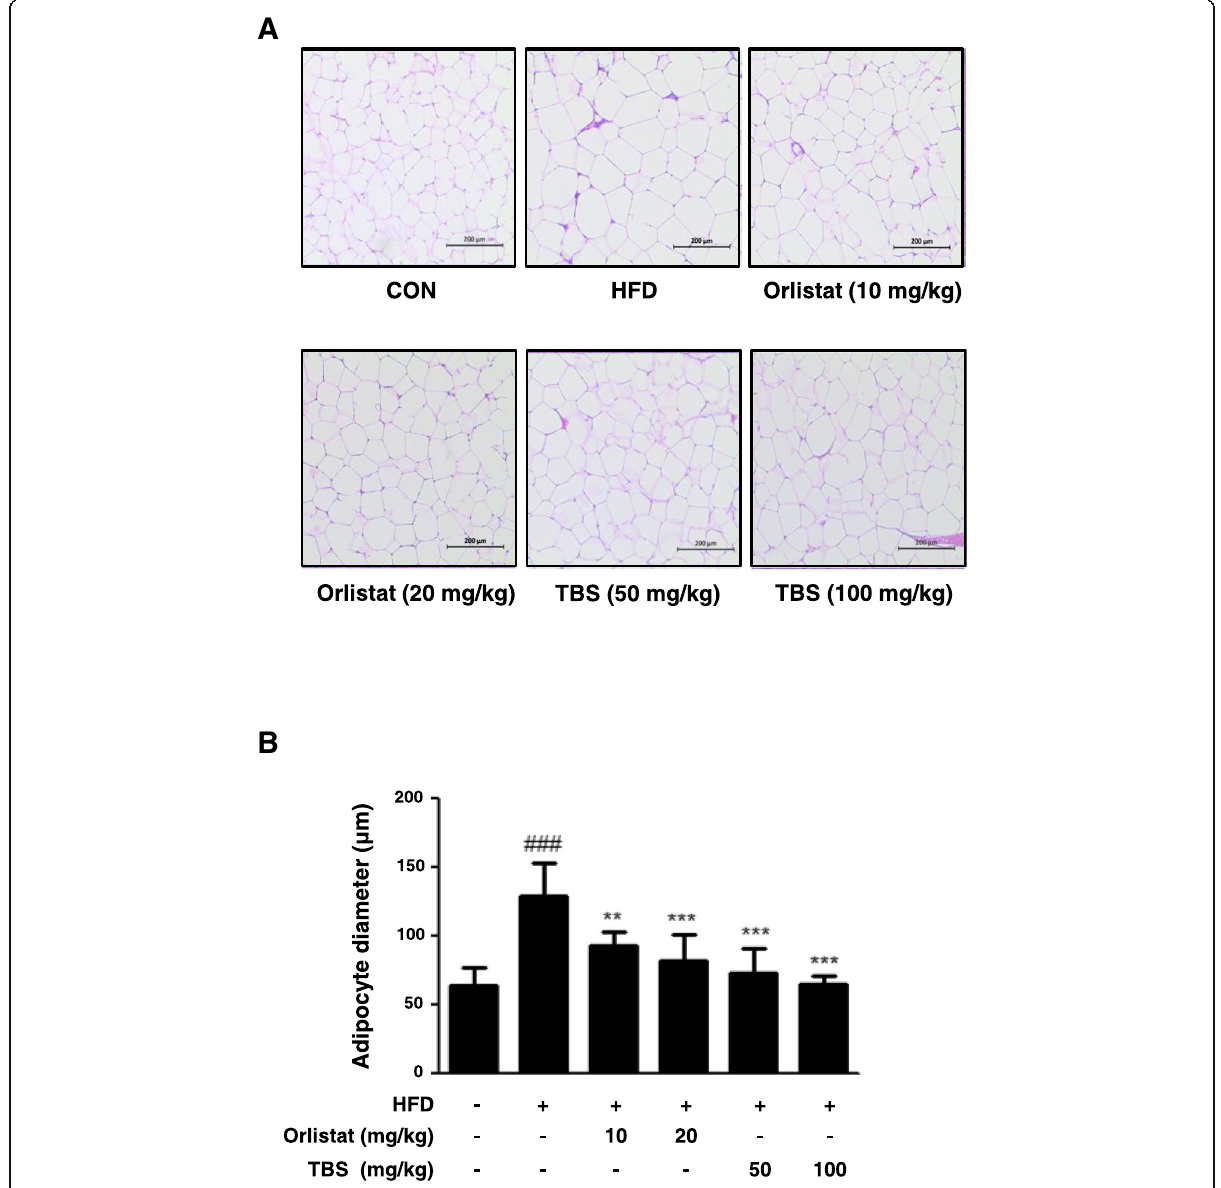
Fig. 3 Effects of TBS on lipid accumulation in epididymal white adipose tissue. (a ) The epididymal white adipose tissue (WAT) from representative mice in each group was fixed, embedded in paraffin, and stained with H&E. Images are shown at the original magnification of 100x. ( b ) The average diameter of adipocytes in epididymal WAT of each group. CON: normal diet group; HFD: high-fat diet group; Orlistat: HFD plus orlistat (10 or 20 mg/kg) group; TBS: HFD plus TBS (50 or 100 mg/kg) group. The values represent the mean ± S.D. of three independent experiments. ### p < 0.001 vs. the control group; ** p < 0.01 and *** p < 0.001 vs. HFD group. Scale bar is 200 μ